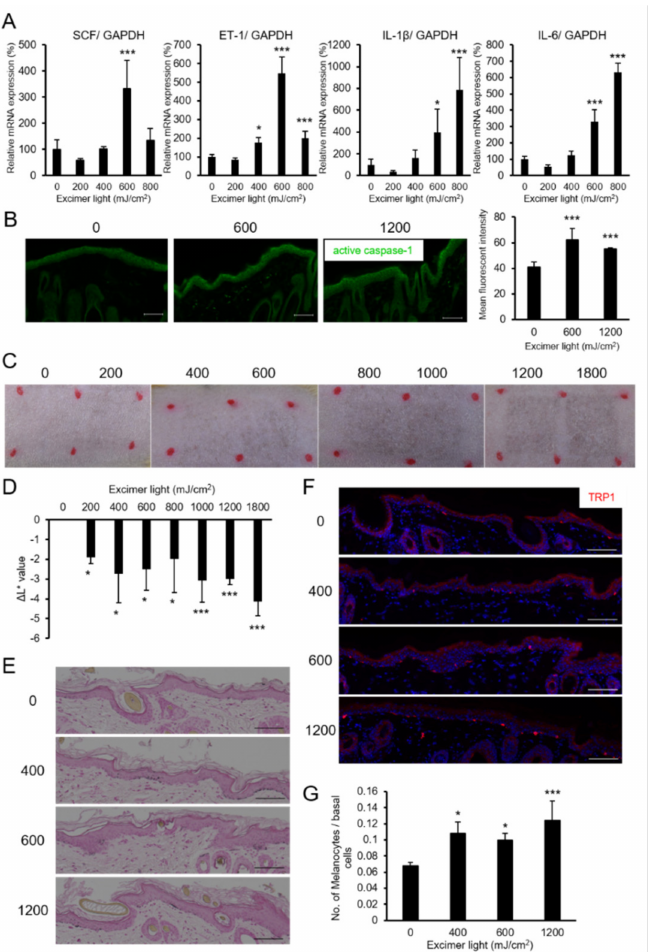
Figure 4. Monochromatic excimer light (MEL) irradiation induced skin pigmentation and melanocyte expansion in guinea pigs. ( A ) The mRNA levels of SCF, ET-1, IL-1 β , and IL-6 were quantitated in the skin after 24 h irradiation with the indicated dose of MEL. ( B ) Immunofluorescence staining of active caspase-1 in the MEL-irradiated skin. Scale bars: 100 µ m. The graph ( B , right) shows the relative quantitation of active caspase-1 levels. ( C ) Representative examples of the skin after 14 days irradiation with the indicated dose (mJ/cm 2 ) of MEL. ( D ) L* values of the irradiated skin on day 14. ( E ) Fontana–Masson melanin staining and ( F ) immunofluorescent staining for the melanocyte marker TRP1 at 14 days after irradiation using MEL with the indicated dose (mJ/cm 2 ). Scale bars: 100 µ m. ( G ) Quantitation of epidermal melanocytes from the skin of three guinea pigs for each condition. Data are shown as the means ± SD, * p < 0.05; *** p < 0.01; one-way analysis of variance followed by Dunnett’s test vs. 0 mJ/cm 2